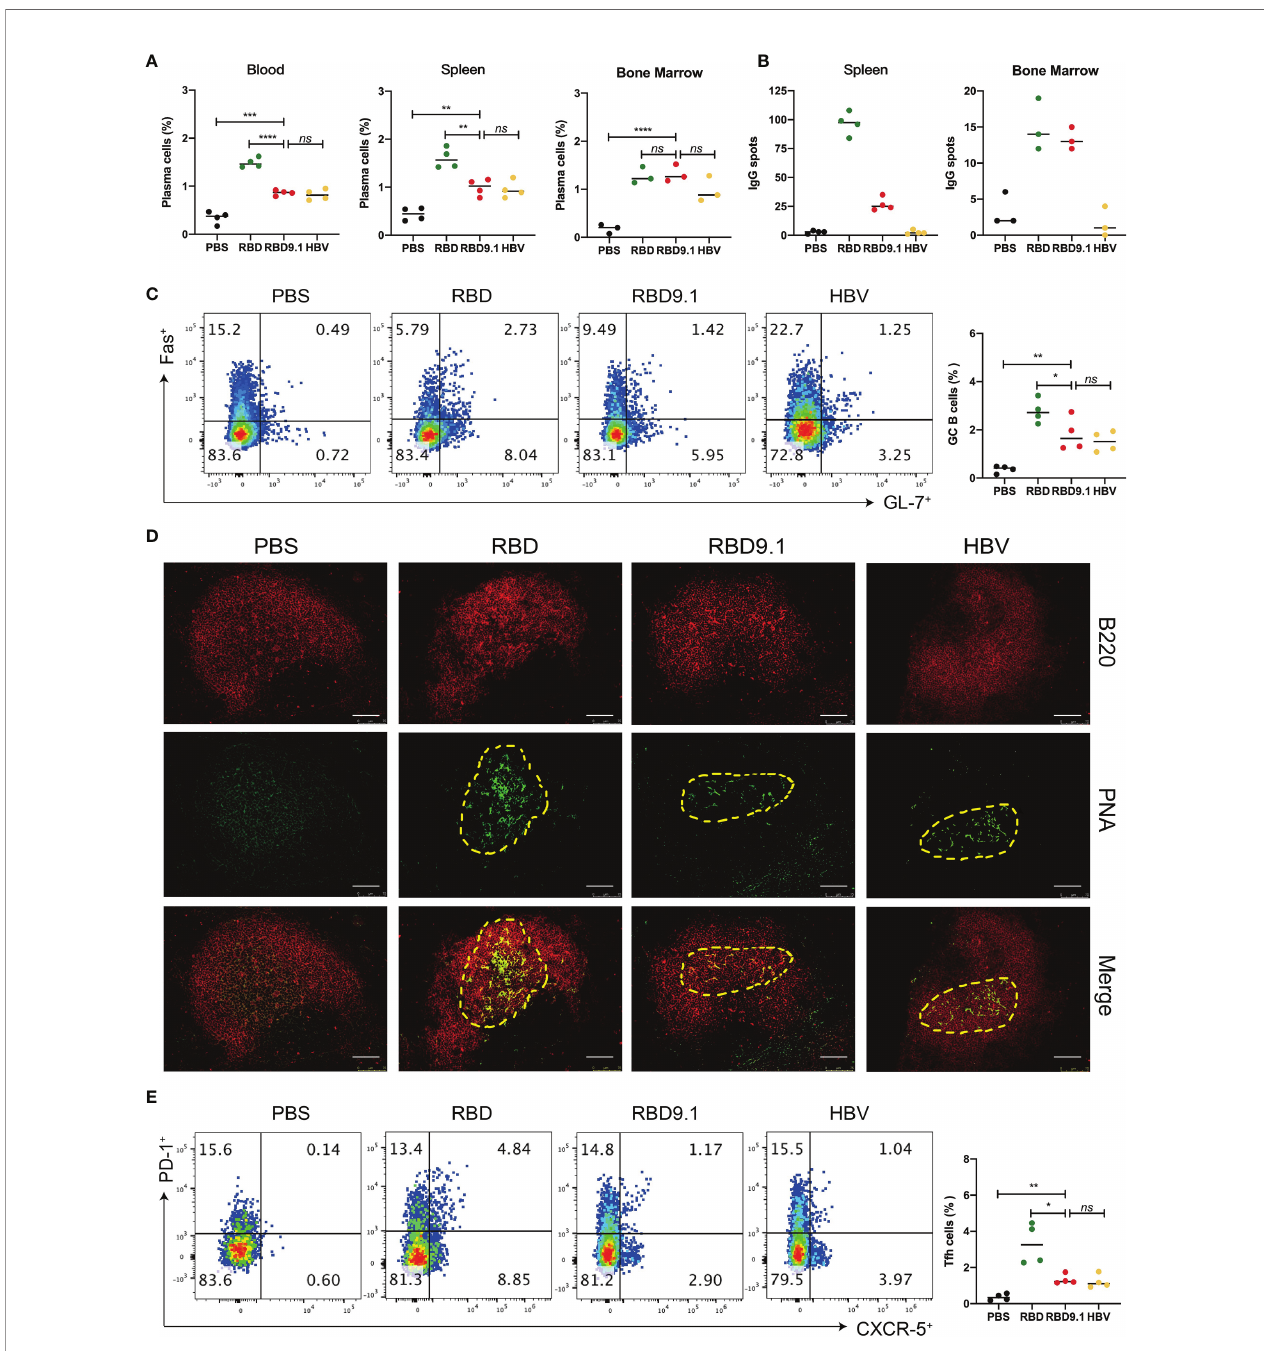
FIGURE 3 | RBD9.1 ef fi ciently activated the germinal center reaction. (A) The ratio of CD19 - CD138 + plasma cells of lymphocytes in the blood, spleen, and bone marrow of mice on the seventh day after the last immunization. (B) Results were expressed as the numbers of receptor-binding domain (RBD)-speci fi c immunoglobulin G (IgG) spots per 5 × 10 5 splenocytes of each mouse subtracted the numbers from the corresponding DMSO groups. The stimulation with an equal volume of media was performed as the negative control. Data were representative of two independent experiments. (C) The percentages of Fas + GL-7 + B cells from the splenocytes were shown in gated CD19 + B cells. (D) On the seventh day after the last immunization, the frozen tissue of the mouse spleen was stained with PNA (green) and B220 (red). The scale bar represented 75 m m, and the picture was analyzed by ImageJ software. (E) The percentages of PD-1 + CXCR5 + T follicular helper (Tfh) cells from the splenocytes were shown in gated CD4 + T cells. Points represent individual mice. * P < 0.05, ** P < 0.01, *** P < 0.001, **** P < 0.0001; ns, non-signi fi